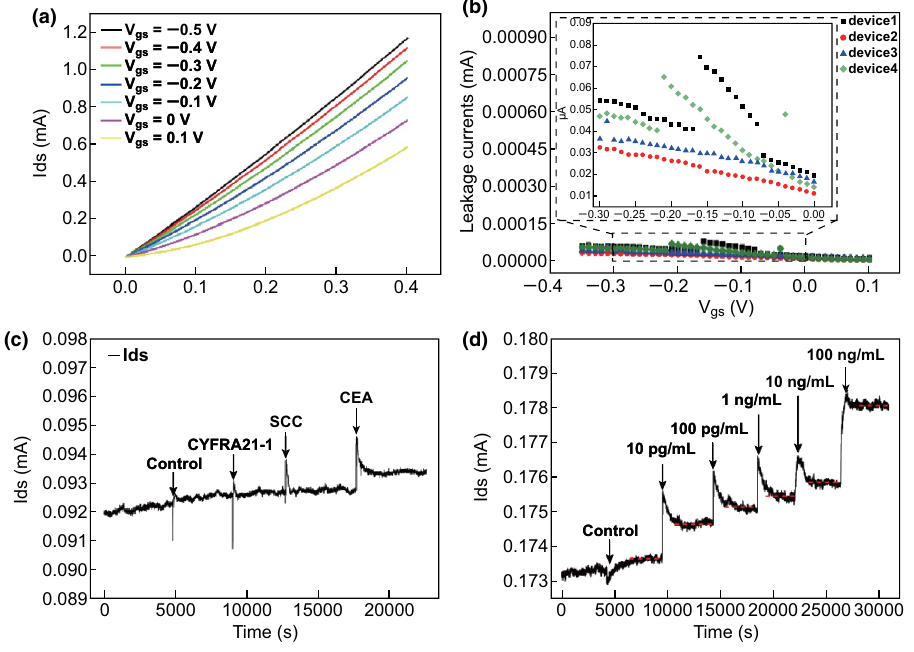
Fig. 4 a Output characteristics of the anti‑CEA‑dBSA functionalized GFET. b Leakage current of the anti‑CEA‑dBSA functionalized GFET. c Drain–source current curve responses to control group, CYFRA21‑1, SCC, and CEA. d Monitoring of drain–source current with increasing CEA concentrations (10 pg mL −1 , 100 pg mL −1 , 1 ng mL −1 , 10 ng mL −1 , and 100 ng mL −1